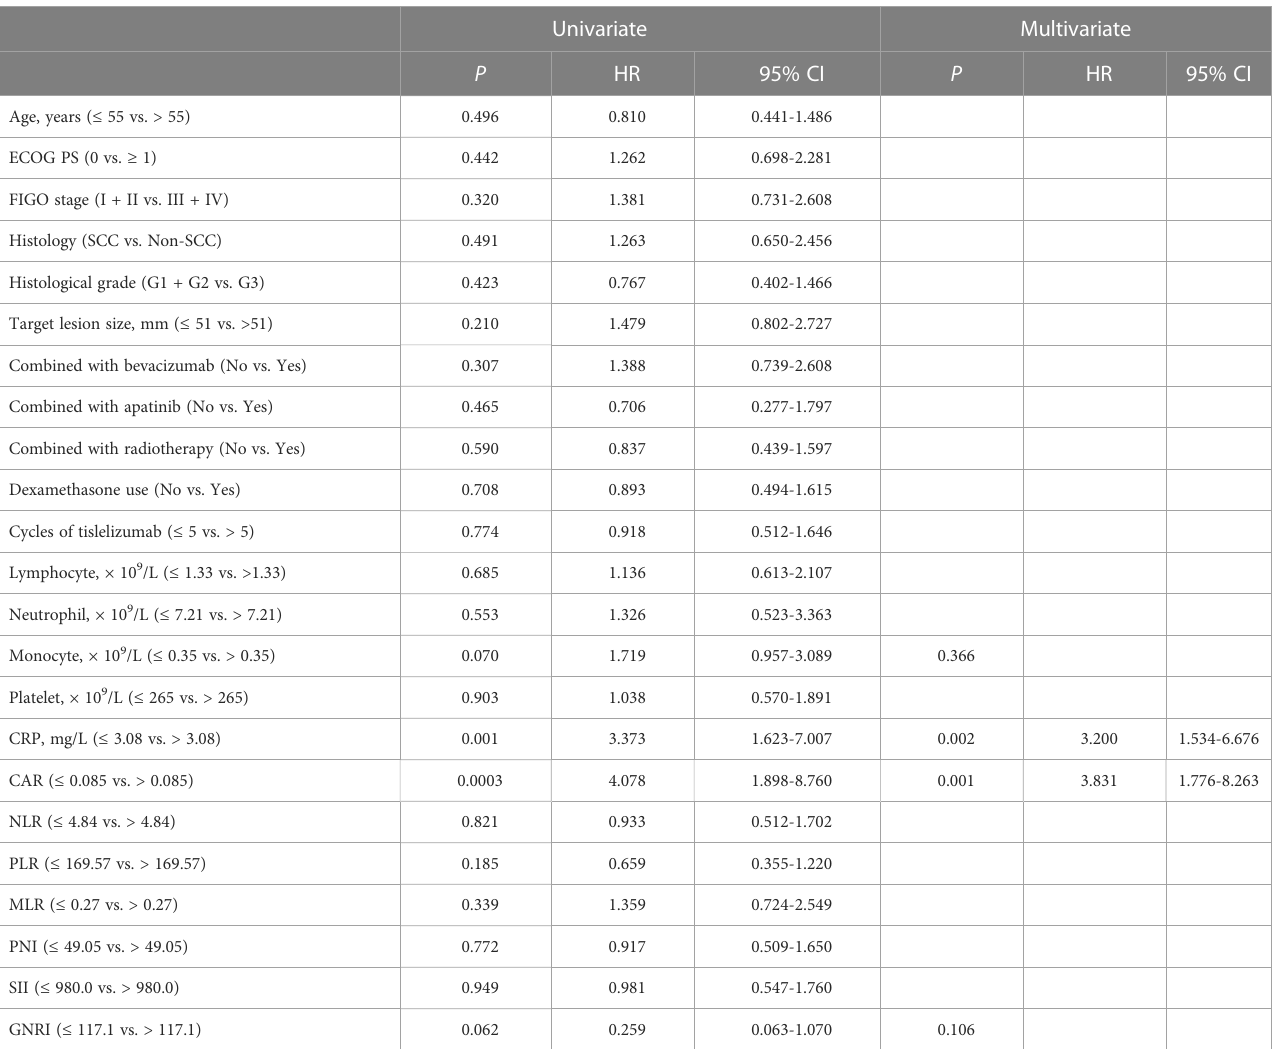
TABLE 6 Univariate and multivariate analyses of PFS.